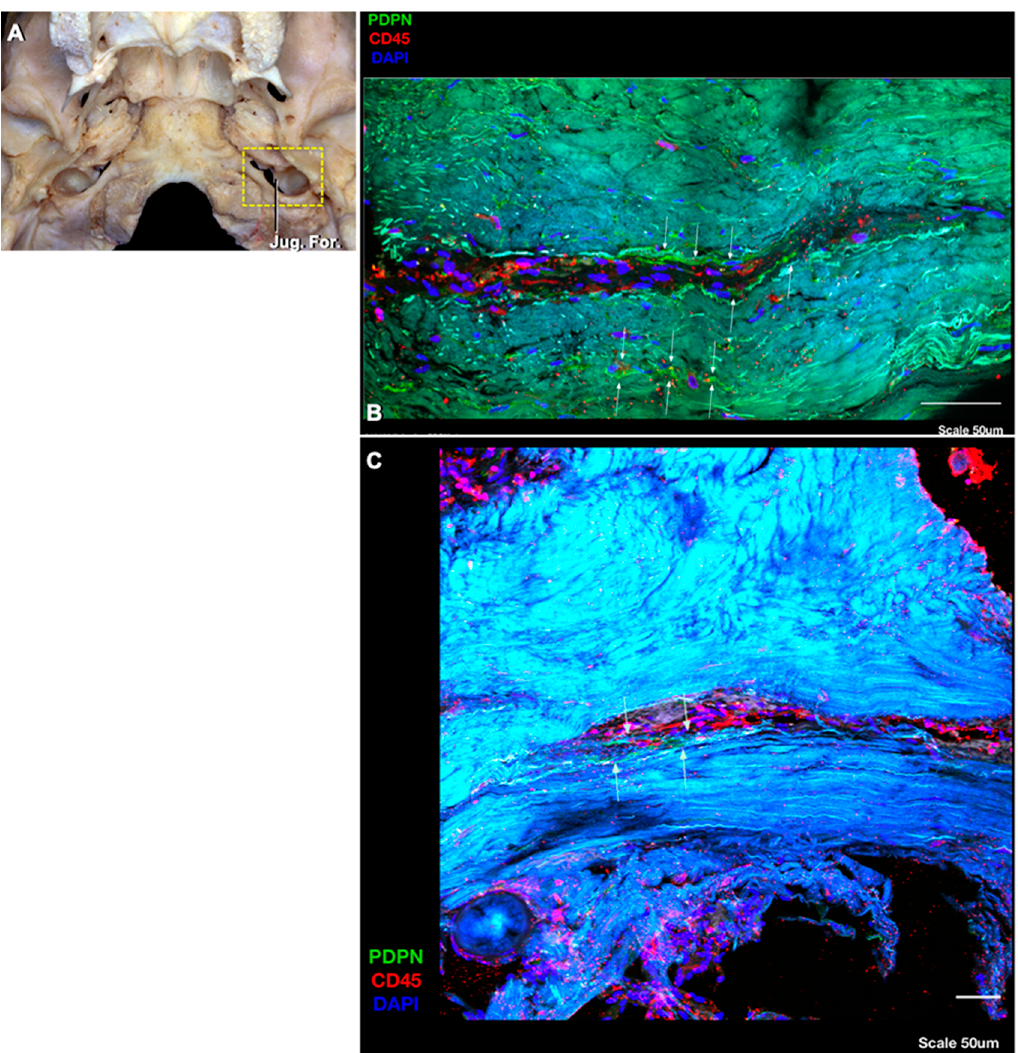
Figure 3. Immunohistochemical staining of the wall of the jugular foramen. ( A ) An inferior view of the skull. The shaded area indicates the jugular foramen and location of sample harvest. ( B ) The immunohistochemical staining of the wall of the jugular foramen, the lymphatic structure (white arrows) along the wall stained positively with PDPN antibody (green colored), and immune cells (T cells) stained by CD45 antibody (red colored) within the lymphatic structure. The DAPI marks the nuclei. ( C ) Another specimen; the lymphatic vessels (white arrows) were seen with staining of PDPN and CD45. Abbreviations: DAPI, 4 ′ 6-diamidino-2-phenylindole; For., foramen; Jug., jugular; PDPN, podoplanin.